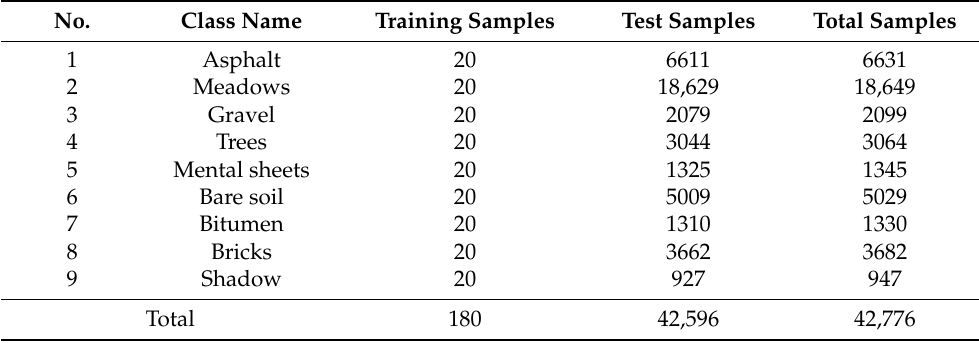
Table 2. Land cover classes and numbers of samples in the Pavia University